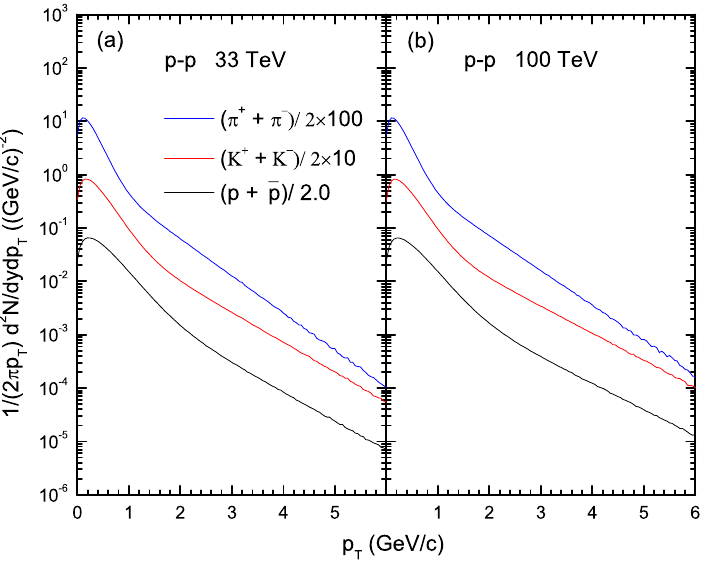
Figure 5. (Color online) The the transverse momentum spectra of pions, kaons and protons in pp (or √ pp ) collisions at s NN = 33 TeV and 100